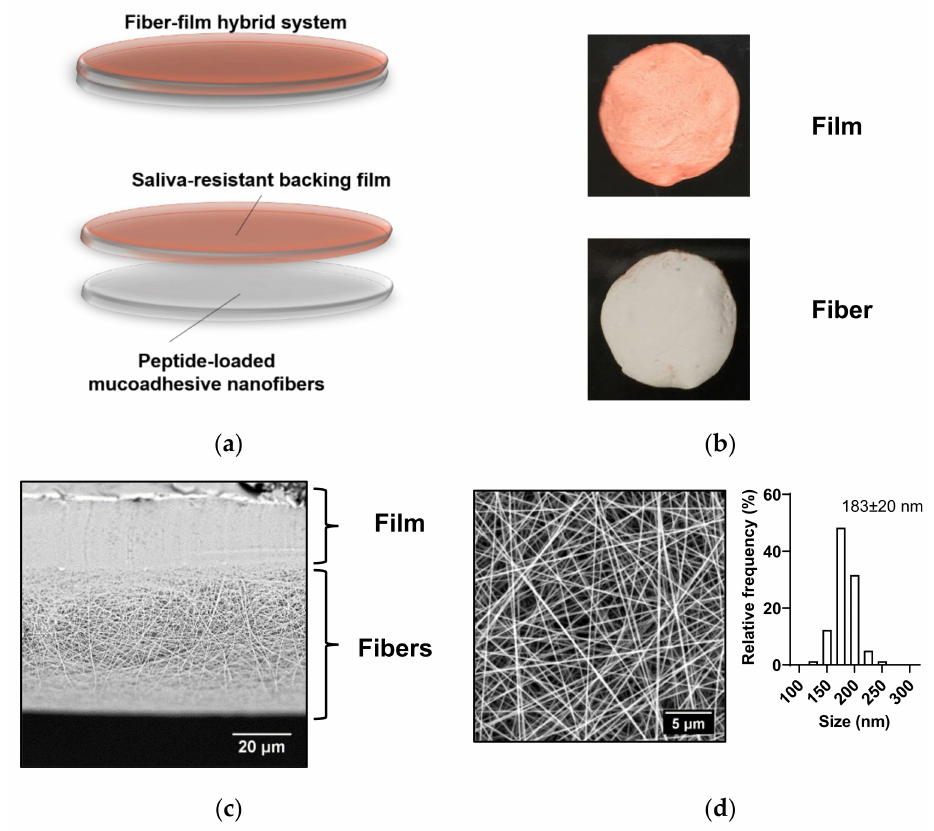
Figure 1. Properties of the desmopressin-loaded nanofiber–film hybrid system. ( a ) Schematic representation of the nanofiber–film hybrid system. ( b ) Image of a 10 mm disc of the two-sided nanofiber–film hybrid system. ( c ) Cross-section of peptide-loaded nanofiber–film hybrid system visualized by SEM. ( d ) Desmopressin-loaded chitosan/PEO nanofibers visualized by SEM. The